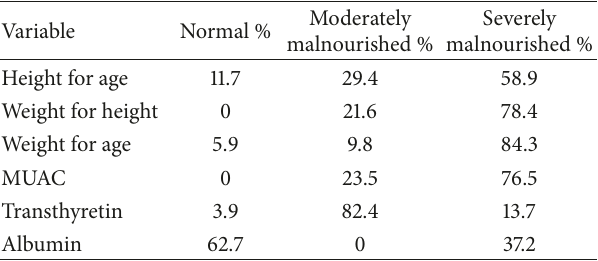
Table 3: Prevalence of malnutrition assessed by different methods among 51 malnourished